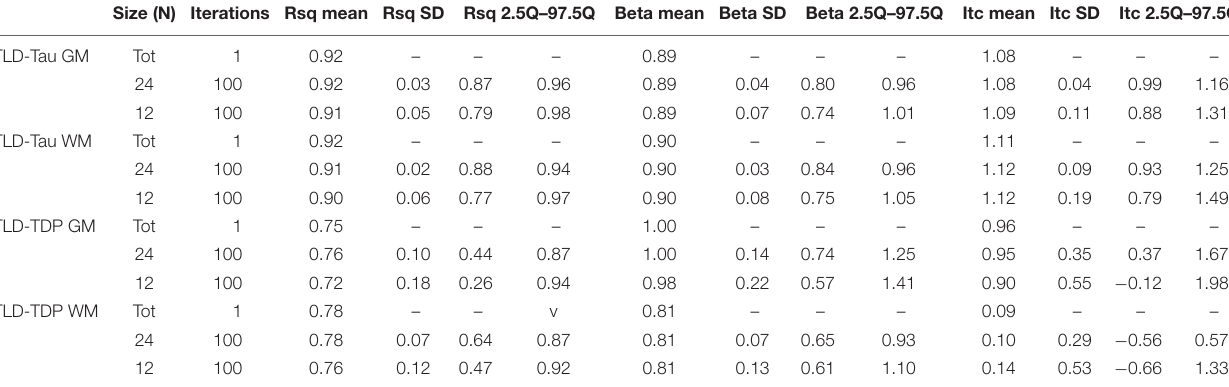
TABLE 2 | Transformation prerequisites and equivalence factors from iterated ( × 100) linear regression in feasible-sized training sets (Step 1).